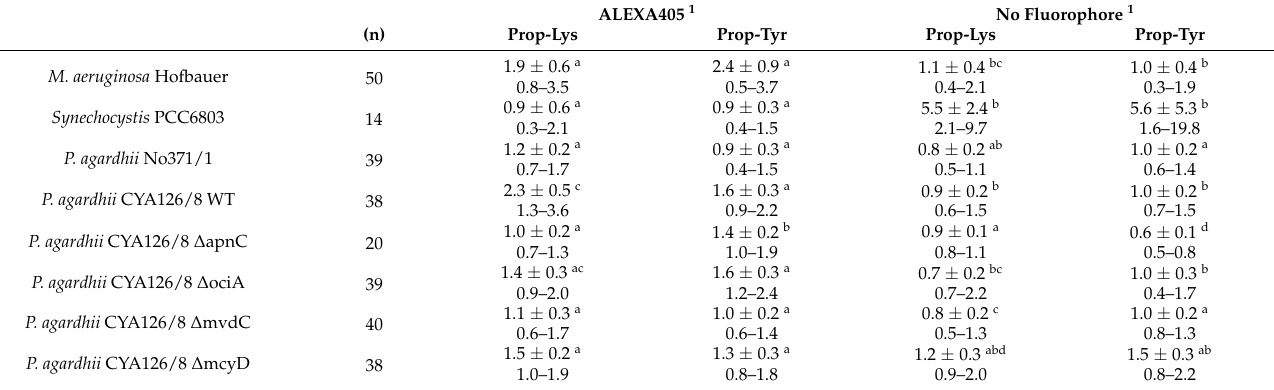
Table 3. Average ( ± SD) min–max blue fluorescence intensity obtained for individual treatments using non-natural amino acid feeding (Prop-Lys and Prop-Tyr) and subsequent labeling by ALEXA405 using copper-catalyzed azide-alkyne cycloaddition (CuAAC). The intensity was divided by the average intensity of control filaments or cells, i.e., cells were grown without amino acid addition but used for the chemical reaction under identical conditions. No Fluorophore indicates filaments or cells grown with amino acid addition but no subsequent labeling by the click-chemical reaction. n: number of individual filaments ( Planktothrix ) or cells ( Microcystis, Synechocystis ). ALEXA405 1 No Fluorophore 1 (n) Prop-Lys Prop-Tyr Prop-Lys Prop-Tyr